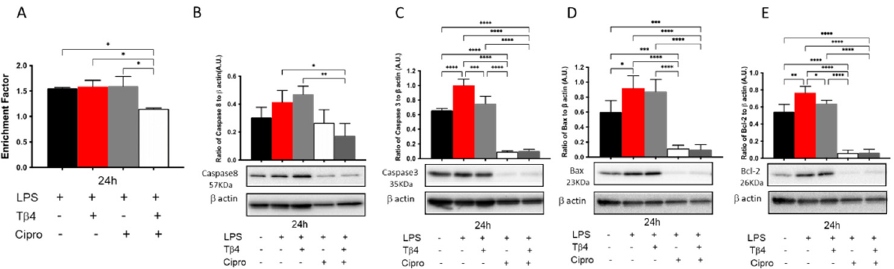
Figure 8. In vitro assessment of apoptotic activity following LPS-induced stimulation of peritoneal- derived PMNs. Cytoplasmic DNA fragments ( A ), caspase-8 ( B ), caspase-3 ( C ), Bax ( D ), and Bcl-2 ( E ) were assessed after T β 4, cipro, and adjunct T β 4 treatments. Levels as detected by Western blot are presented as a ratio to β -actin ± SD. n = 3; * p < 0.05, ** p < 0.01; *** p < 0.001, and **** p < 0.0001.